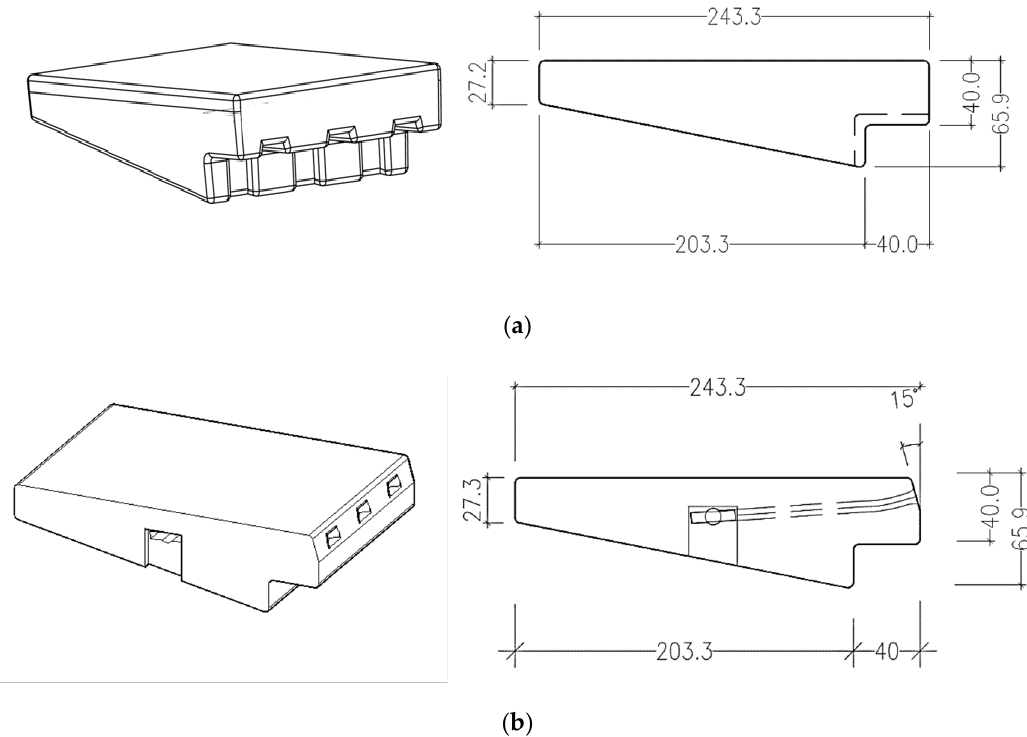
Figure 7. A 3D view and longitudinal section of the WSBs tested during the experimental research: ( a ) WSB Armorwedge™ and ( b ) WSB ACUÑA (dimensions in mm, the width of both block types: 165 mm) [30].